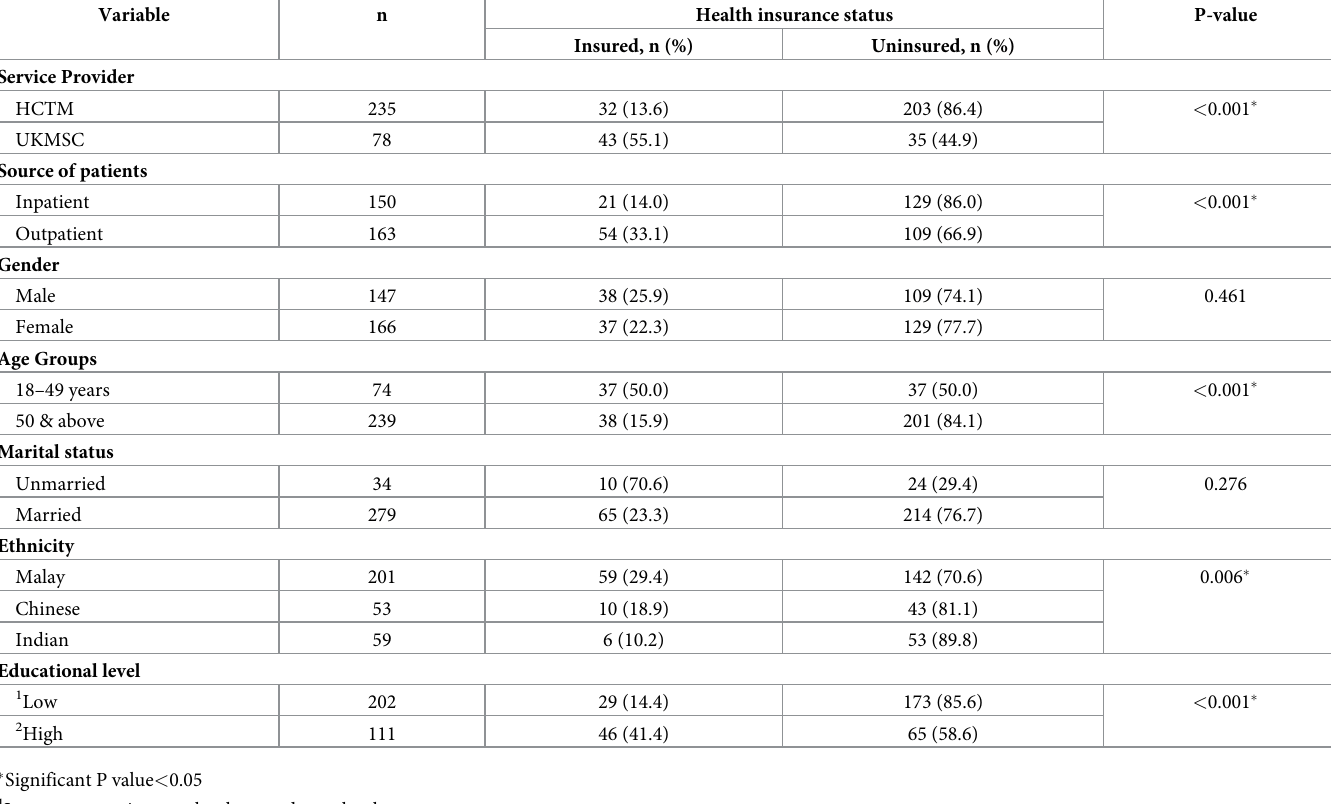
Table 3. Association between health insurance status and sociodemographic